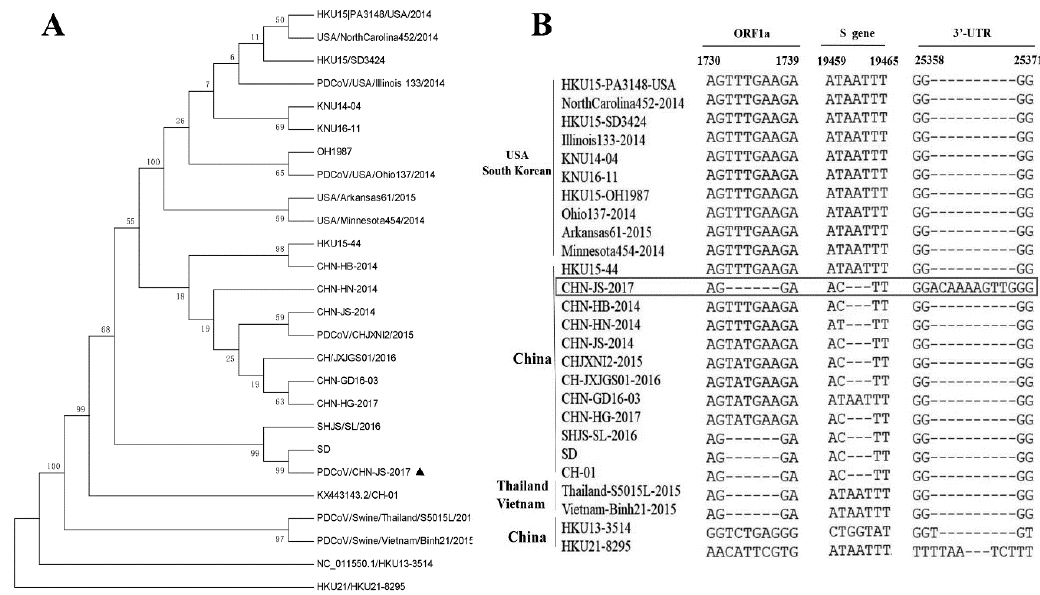
Figure 2. A phylogenetic tree constructed on the basis of the complete genome ( A ) of the PDCoV strain from di ff erent countries and local areas. CHN-JS-2017 is represented by a triangle. The phylogenetic tree was constructed by the adjacency method in MEGA 7 (http: // www.megasoftware.net). Bootstrap analysis was performed using 1000 replicates. ( B ) Three main deletions or insertions in the complete genome alignment. A multiple sequence alignment was constructed with ClustalW in the DNAStar software. The PDCoV strain CHN-JS-2017 is indicated in bold and highlighted with a box.